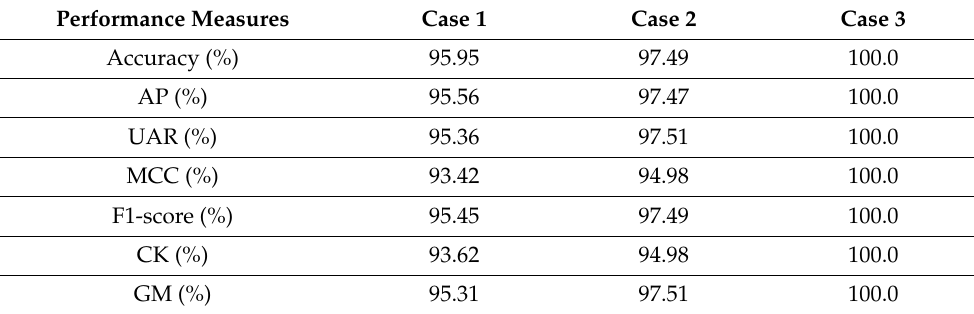
Table 3. Summary of overall performance (%) obtained for the three cases.